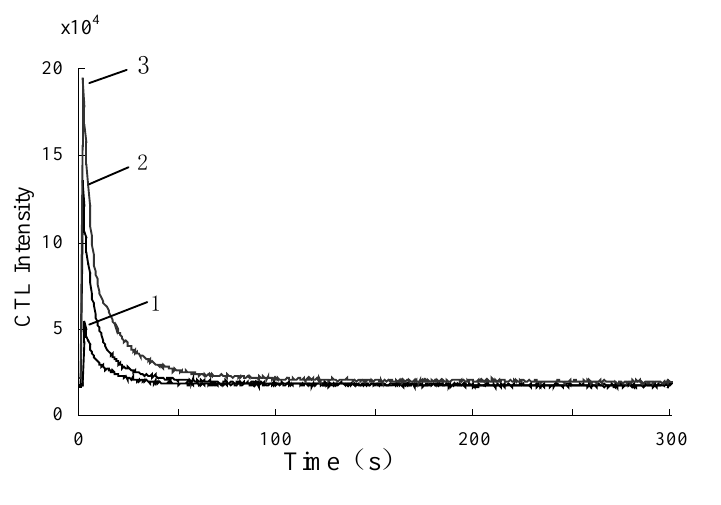
Figure 4. Wavelength dependence of CTL intensity of benzene vapor (432 ºC, 200 mL/min, 4483 mL/m 3